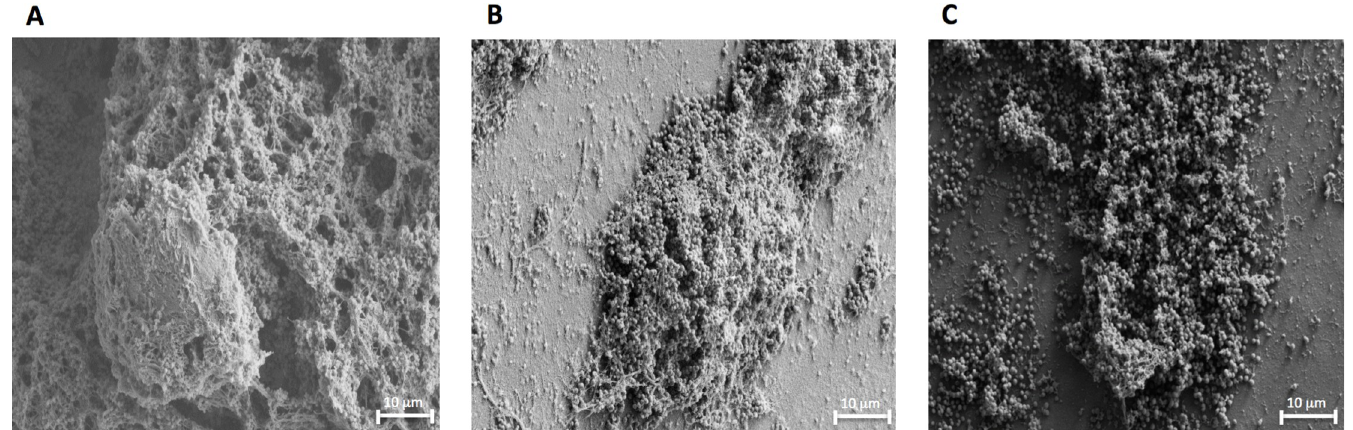
Fig 4. SEM analysis of representative MSSA biofilms. Biofilms were allowed to form onto titanium coupons for 72 hours and subsequently treated with 1% CAGE for a) 0, b) 5, and c) 60 minutes.